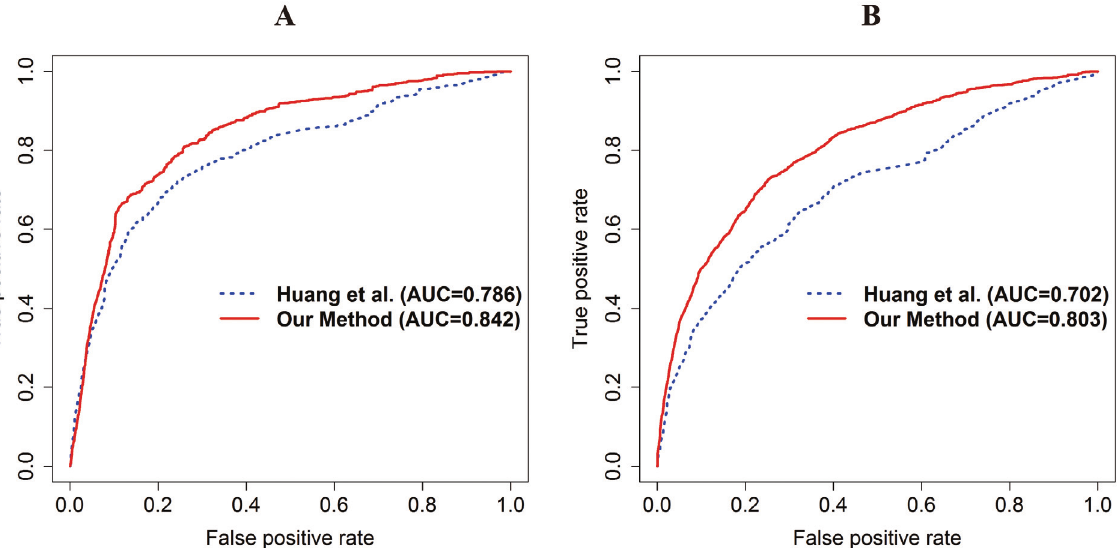
Fig 3. ROC curve with AUC in DrugBank and KEGG DRUG for comparison with Huang et al . ’ s method using the integrated PPI network. The red and blue lines represent our method and Huang et al . ’ s method, respectively. (A) The ROC curve with the AUC of our method and Huang et al . ’ s method in DrugBank. (B) The ROC curve with the AUC of our method and Huang et al . ’ s method in KEGG DRUG. The AUC of our method and Huang et al . ’ s method in each DDI database are 0.842 and 0.786 in DrugBank and 0.803 and 0.702 in KEGG DRUG. The performance of our method generally outperforms that of Huang et al . ’ s method.